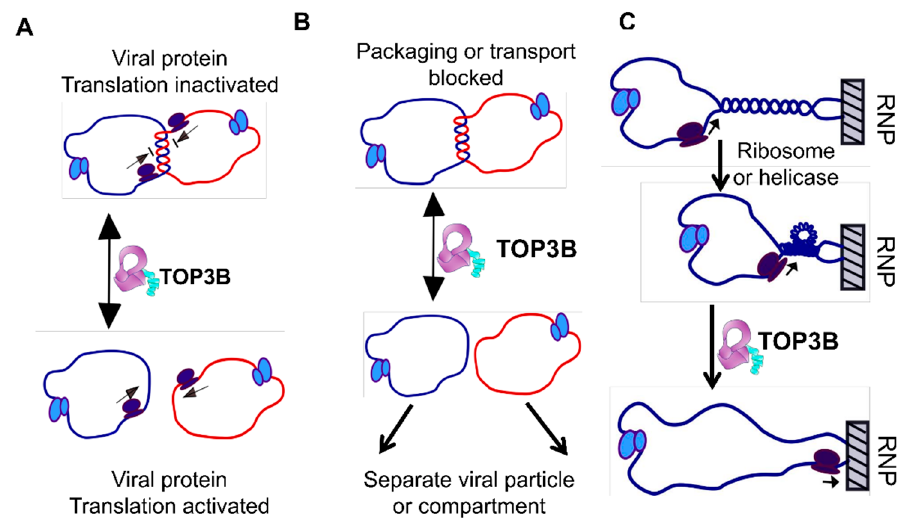
Figure 1. Some of the potential topological problems during the life cycle of a positive-sense single- stranded RNA virus that may require the RNA topoisomerase activity of human TOP3B. Genome circularization can be mediated by RNA–RNA interactions and proteins binding to the 5 ′ and 3 ′ ends. Decatenation of the catenated circular viral genome by TOP3B is required to remove blocks of ( A ) viral protein translation, ( B ) viral RNA transport and packaging. ( C ) When a translating ribosome or a helicase unwinds a duplex region in a viral RNA hairpin, and if the hairpin is bound to an immobile RNP or cellular matrix, the helical torsion will need to be relaxed by TOP3B. The figure is modified from a published version for potential TOP3B action on mRNA in [29].